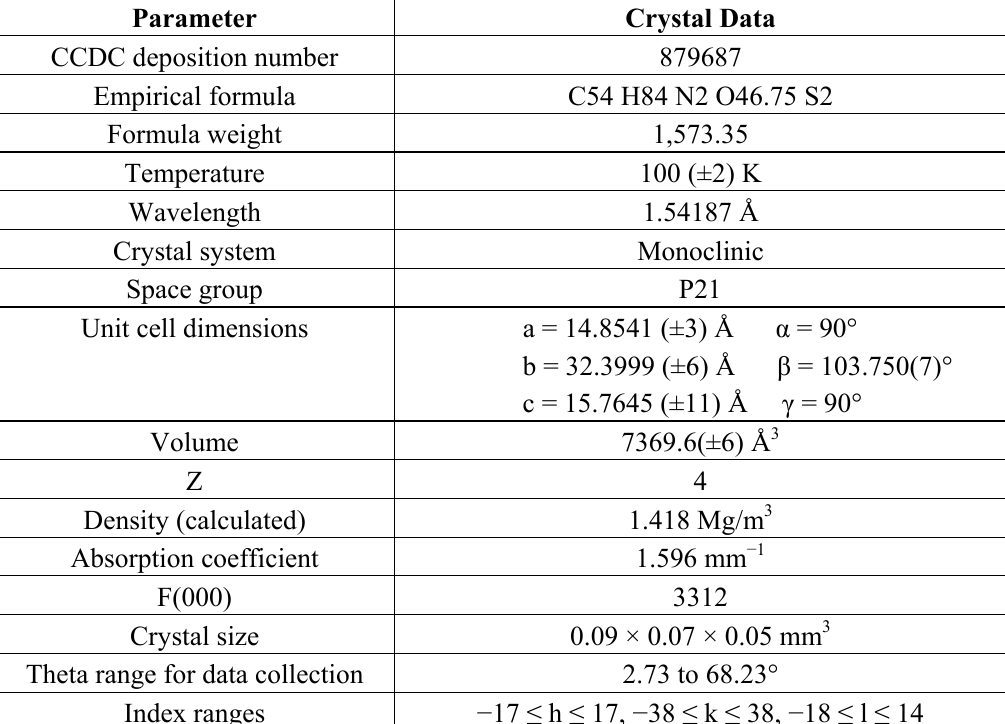
Table 1. Crystal data and structure refinement for 4-ATP/ β